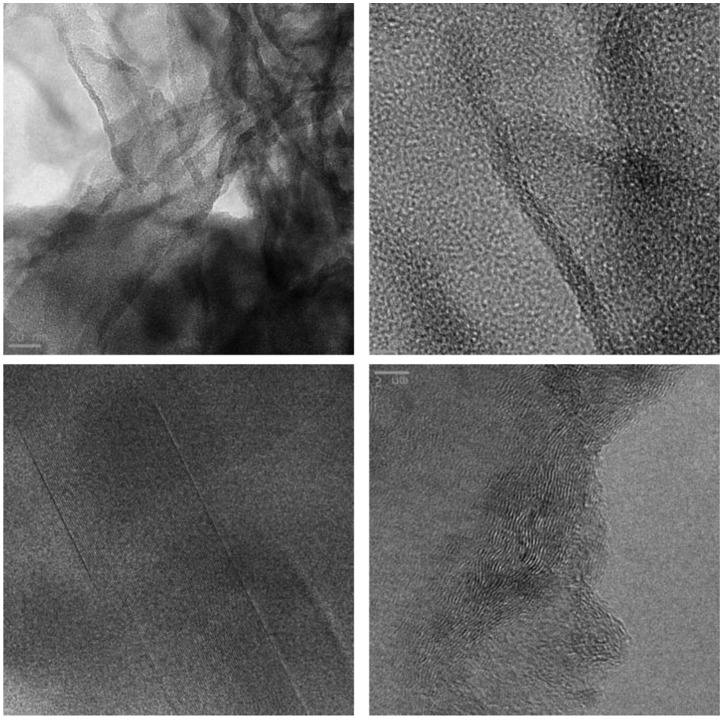
TEM micrographs of S2 (Ccoke/g-C3N4) composite.